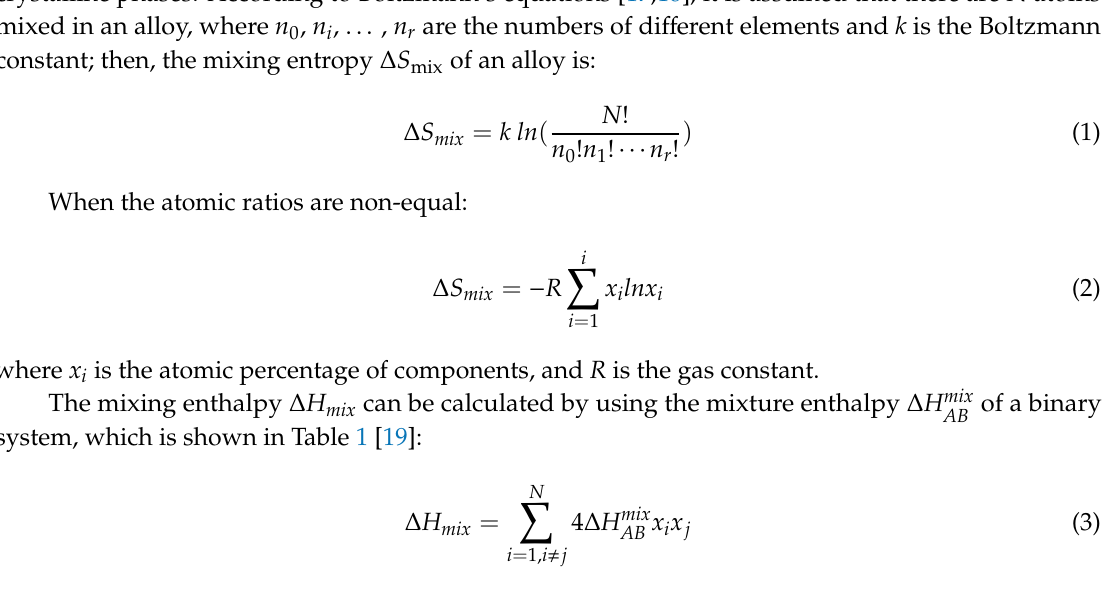
Table 1. Δ𝐻 (cid:3002)(cid:3003)(cid:3040)(cid:3036)(cid:3051) of the binary elements [20] Element